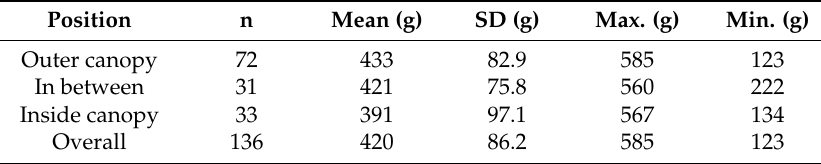
Table 4. Fruit mass at different canopy positions.